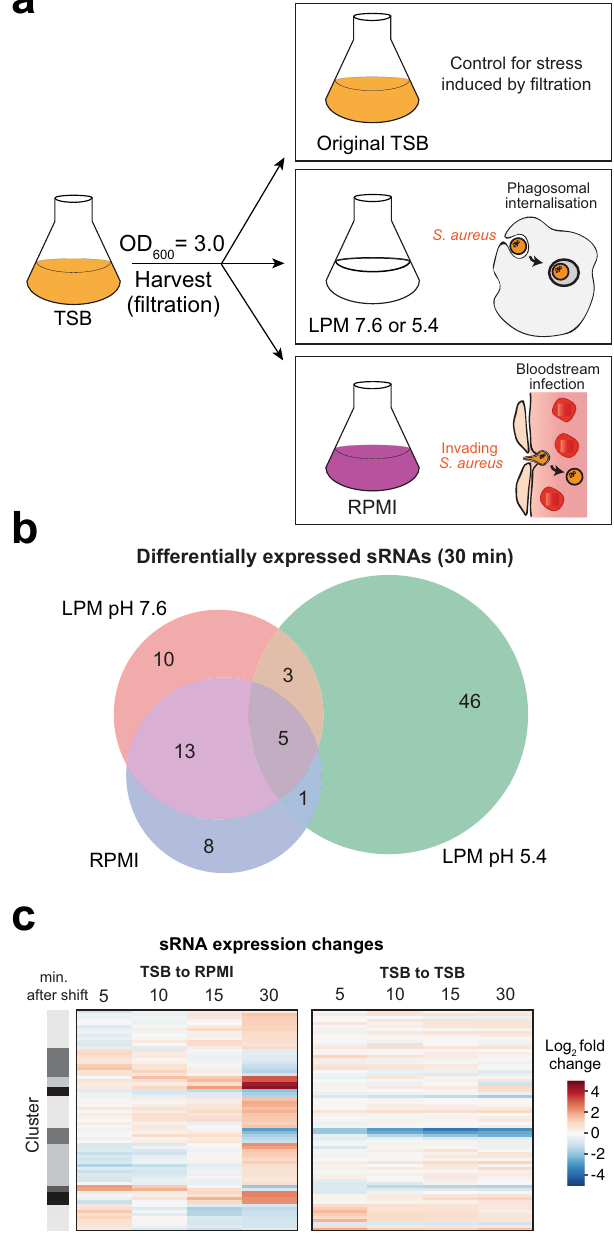
Fig. 1 Mimicking the transition to the bloodstream and intracellular environment. a Experimental set up for shift experiments. S. aureus was grown to OD 600 ~3 in TSB and harvested through vacuum fi ltration. Cells were then resuspended in RPMI to simulate the bloodstream or LPM pH 5.4 to simulate intracellular phagosomes. As controls, cells were shifted into LPM pH 7.6 to model for the nutritional pro fi le of this medium, or back into their original TSB to model for any stresses incurred by the shift. b Number of sRNAs with signi fi cantly changed expression after 30 min of stress. Each stress condition is uniquely coloured, with sRNAs found in LPM pH 7.6 shown in red, LPM pH 5.4 in green and RPMI in blue. c Changes in the expression levels of individual sRNAs during the shift to RPMI and shift back to the original TSB medium. The darker the red in colour, the higher the increase in gene expression. The darker the blue in colour, the stronger the reduction in gene expression. Expression was compared to data obtained from the TSB (t = 0) sample. Only sRNAs that were differentially expressed during the time-course, according to DESeq2 116 , are